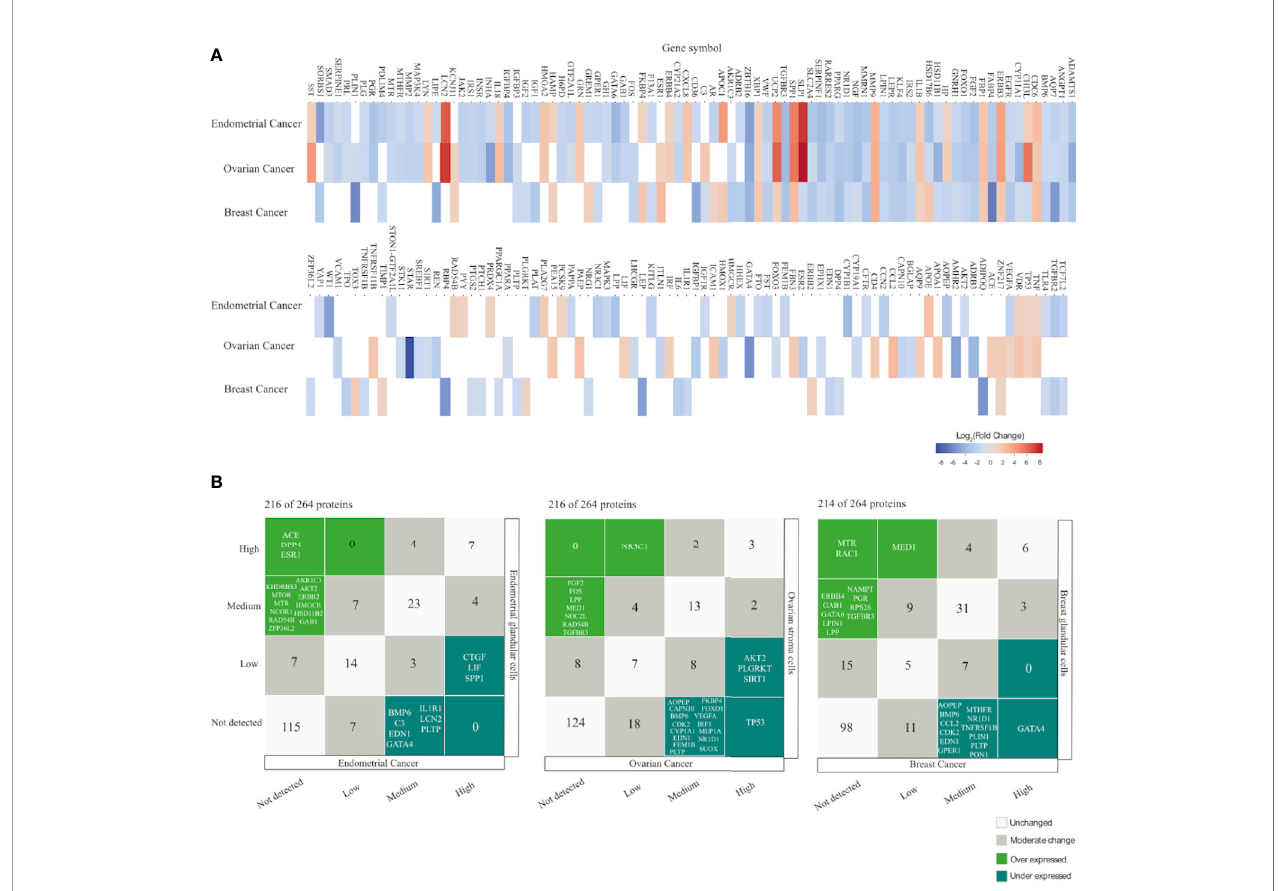
FIGURE 5 | Gene and protein expression pro fi ling of PCOS related genes (PRG) in endometrial, ovarian and breast cancer compared with normal tissue. (A) Heatmap displays the differential expressed genes with |Log2FC| = 1, FDR < 0.001 from GEPIA database. Empty spaces indicate absence of differential expression. (B) Correlation plot comparing immunohistochemical protein expression pro fi le between cancer samples and healthy tissue according to The Human Protein Atlas (HPA) in each cancer